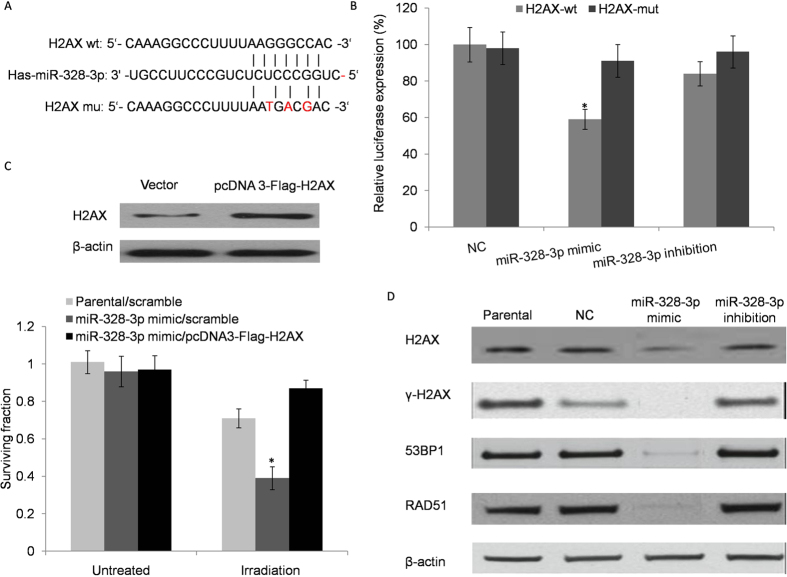
Identification of miR-328-3p directly to the target gene and its influence.(A) miR-328-3p binding to its site in the target gene H2AX. (B) Comparison of luciferase activity in vectors containing H2AX wild or mutation binding sequences. (C) Transient over expression of H2AX reversed the radiation sensitizing effect of miR-328-3p mimic in A549 cells with irradiation treatments. *p < 0.05. (D) Western blot analysis of DSB marker proteins γ-H2AX, H2AX, 53BP1 and RAD51 in A549 cells with miR-328-3p in transfected and non-transfected cells before and after exposure to 8-Gy X-ray irradiation. β-actin used as an internal control. Each experiment was performed in triplicate. Relative expression level demonstrated as gel images below.